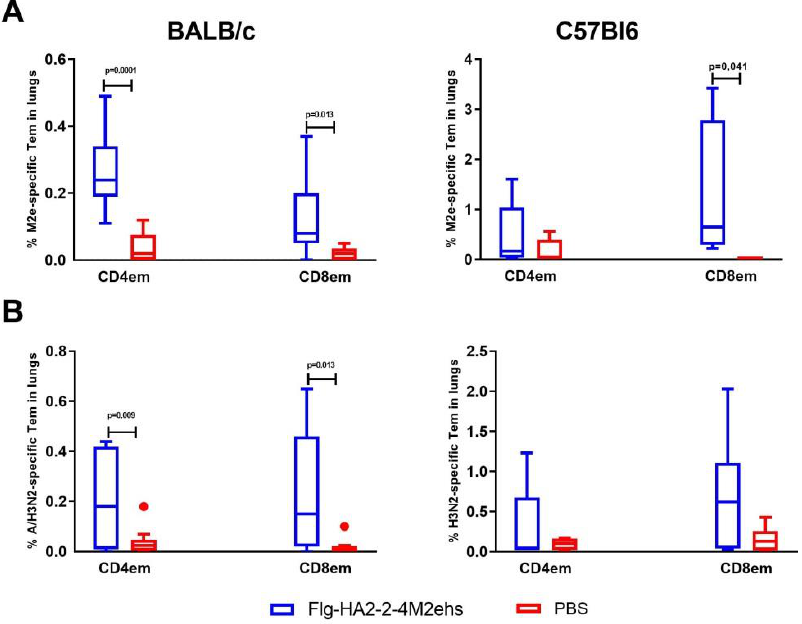
Figure 2. The M2e- ( A ) and A/H3N2-specific ( B ) effector CD4+ and CD8+ memory T cells in lungs after intranasal immunization of BALB/c and C57Bl6 mice with the recombinant protein Flg-HA2-2-4M2ehs. The data are presented as Tukey plots. The data of two experiments ( n = 8) were summarized. Significant differences from the control group are shown.